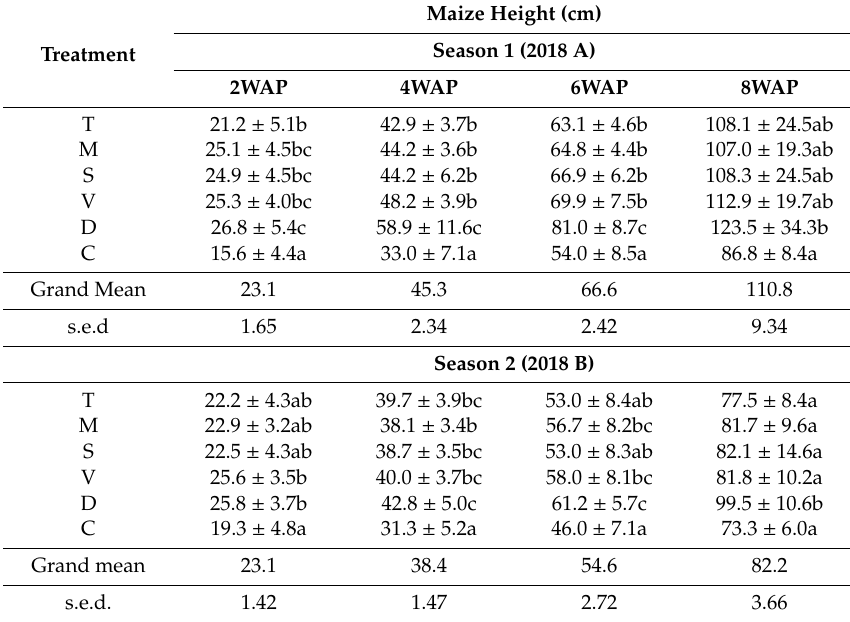
Table 2. Variation of maize plant height in di ff erent treatments over two seasons.